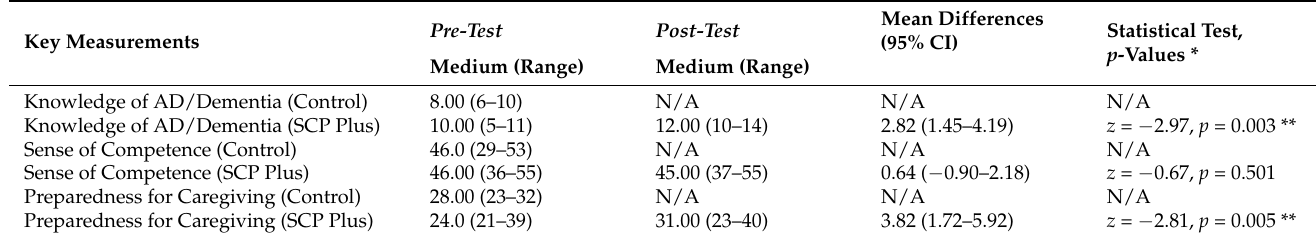
Table 2. Key measurements in pre- and post-tests for SCs in control ( n = 9) and SCP Plus ( n = 11)